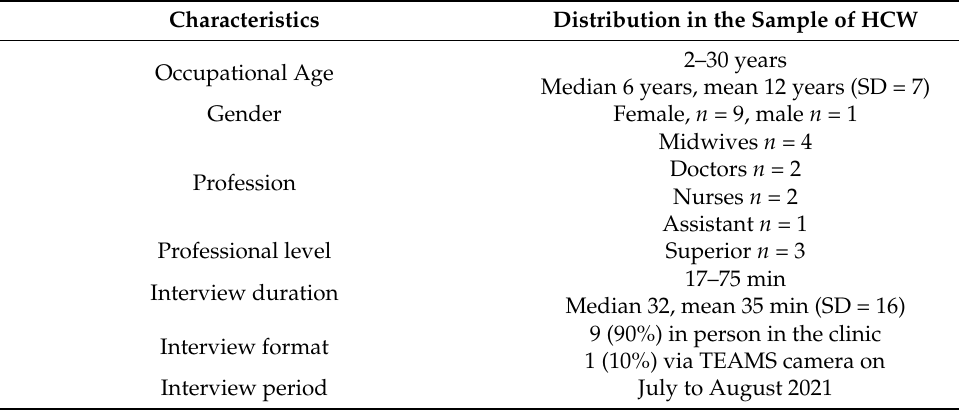
Table 2. Demographics of participating HCWs.